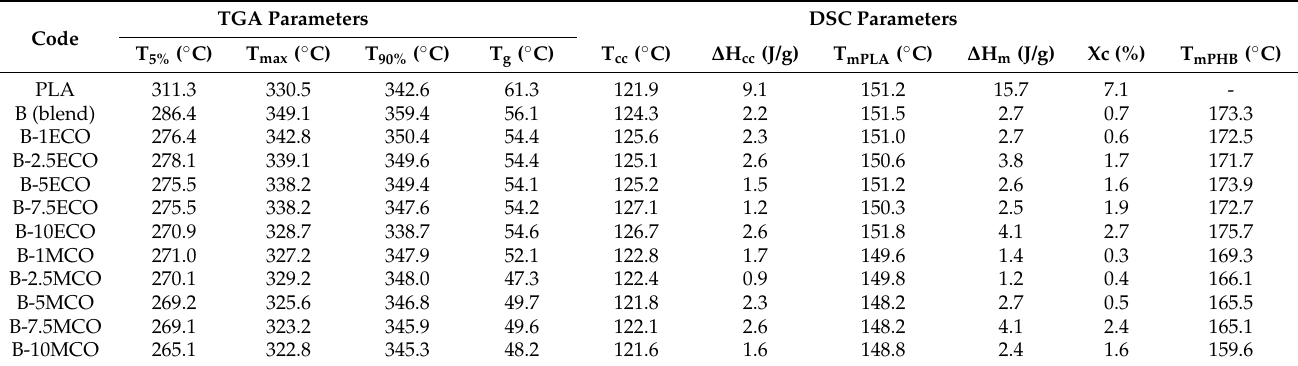
Table 3. Summary of the main thermal parameters of the neat PLA, PLA–PHB blend, and plasticized blend with different ECO and MCO contents.